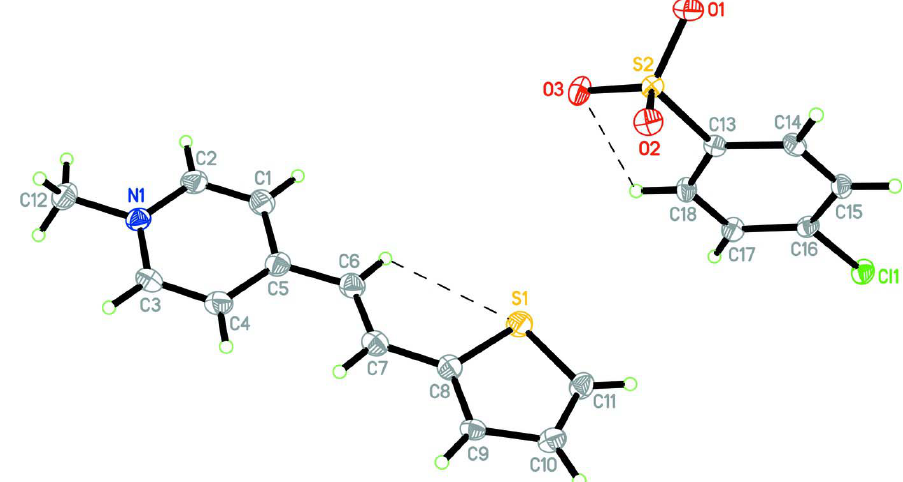
The title molecules showing 50% probability displacement ellipsoids and the atom-numbering scheme. The intramolecular C—H···O and C—H···S weak interactions are drawn as dashed